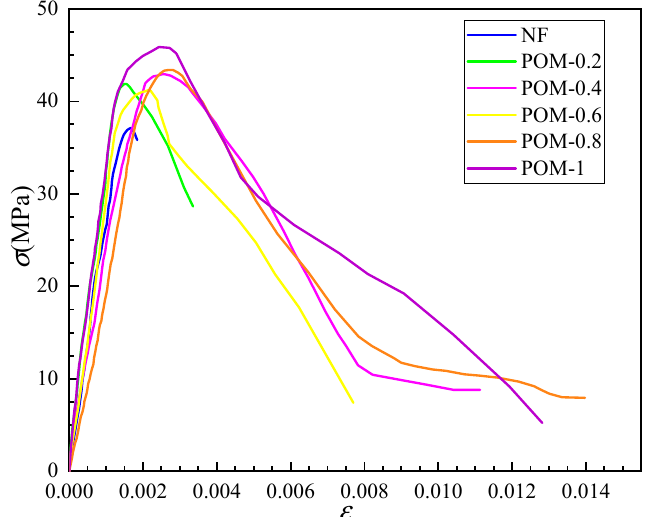
Figure 25. Complete stress–strain curve under uniaxial compression.